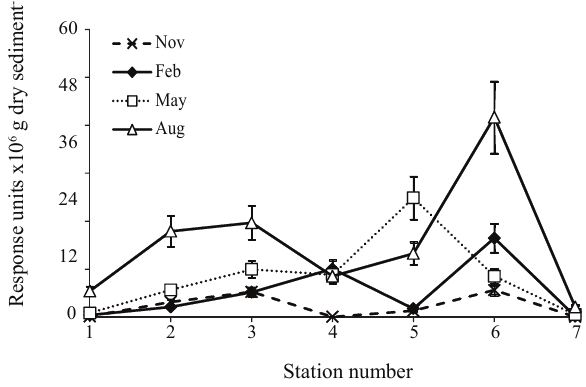
Fig. 3. The HPH crenarchaeol abundance along the sampling tran- sect in the surface